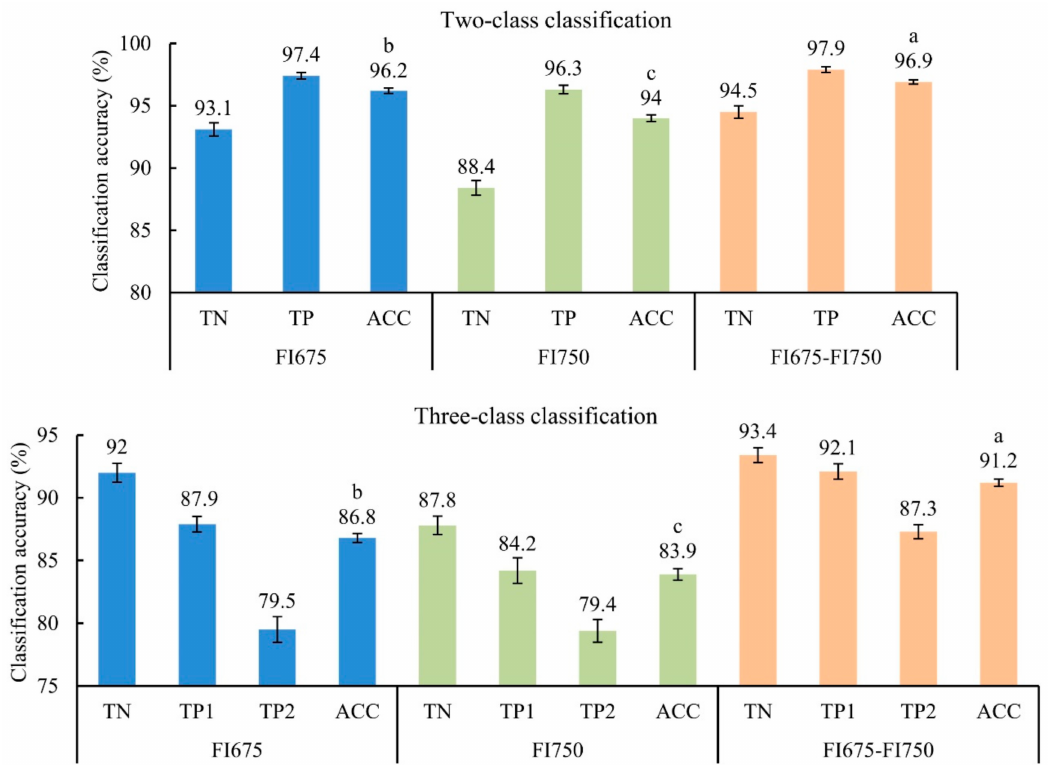
Figure 8. Two-class and three-class classification for chilling injury detection of pickling cucumbers. TN, TP and ACC represent true negative, true positive and overall accuracy, respectively, and TP1 and TP2 represent the true positives for mildly and severely chilled cucumbers, respectively. FI675, FI750 and FI675-FI750 represent the three types of the input of fluorescence images at 675 nm, 750 nm and their combination, respectively. Error bars in the chart indicate the corresponding standard errors for the accuracies over 30 modeling replicates. Different letters in the ACC accuracy indicate statistical difference at the 5% significance